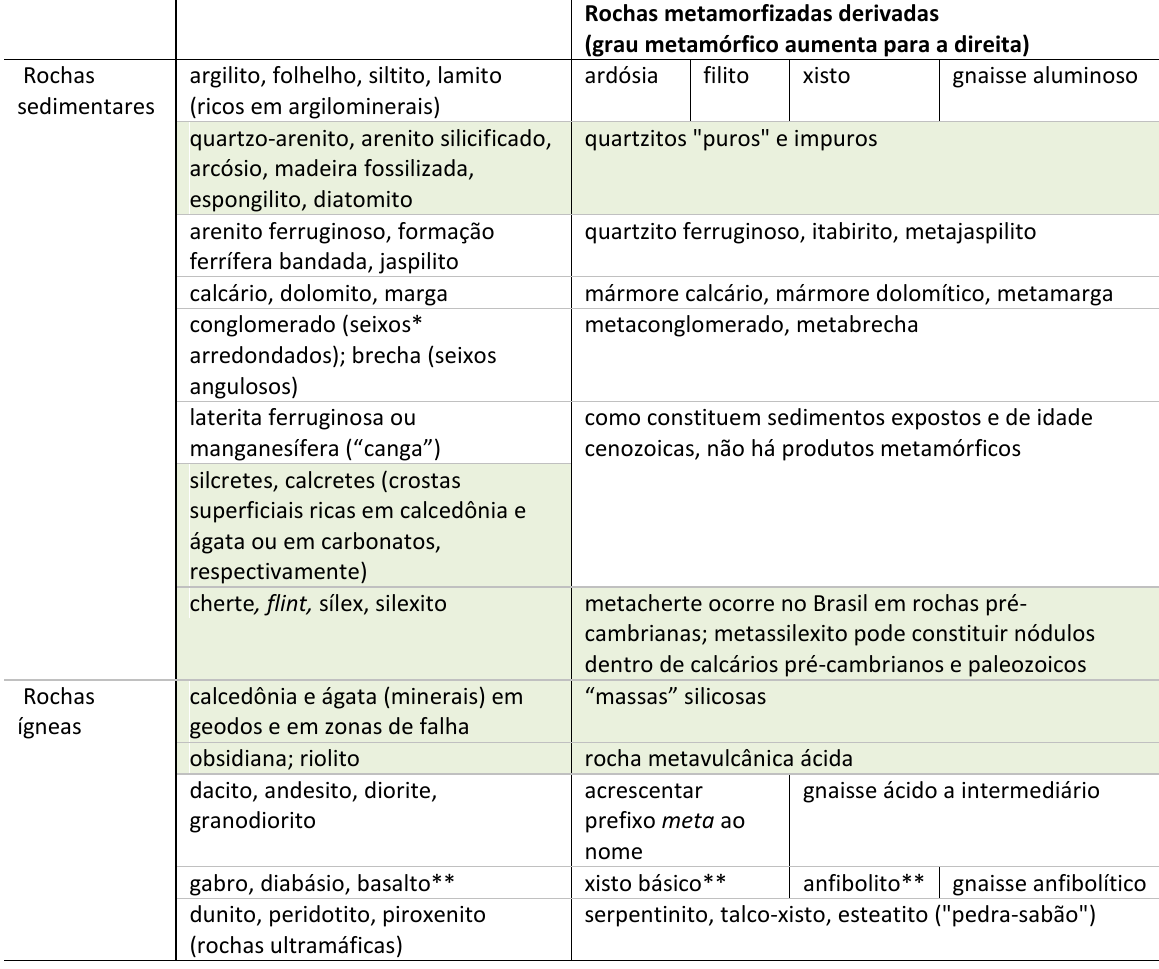
Tabela 1. Resumo simplificado das principais matérias-primas. Em verde, materiais silicosos. Fontes principais: Suguio (1980), Sgarbi (2007), Press et al. (2008), IBGE (1999), Winge (2016). * Embora “seixo” em Sedimentologia designe fragmentos rolados de rochas ou minerais com diâmetro situado entre 4 mm e 6,4 cm, sendo os maiores denominados calhaus (de 6,4 cm a 25,6 cm) e matacões (>25,6 cm), respectivamente (Wentworth 1922), aqui será mantido o termo seixo para todos eles, por ser este um termo de uso corrente em Arqueologia. Table 1. Simplified abstract of the main lithic raw-materials. Siliceous materials are highlighted in green. Main sources: Suguio (1980), Sgarbi (2007), Press et al. (2008), IBGE (1999), Winge